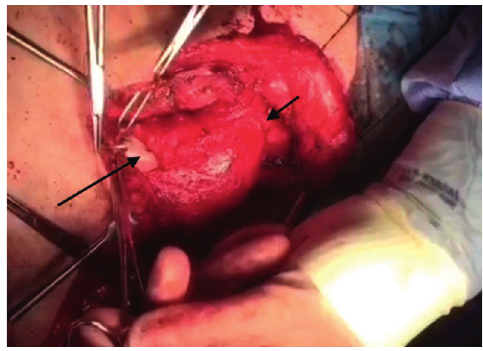
Figure 3: Short arrow indicates anastomosis of flap to oropharynx in proximal. Long arrow indicates anastomosis of rolled flap to cervical esophagus in distal part of the